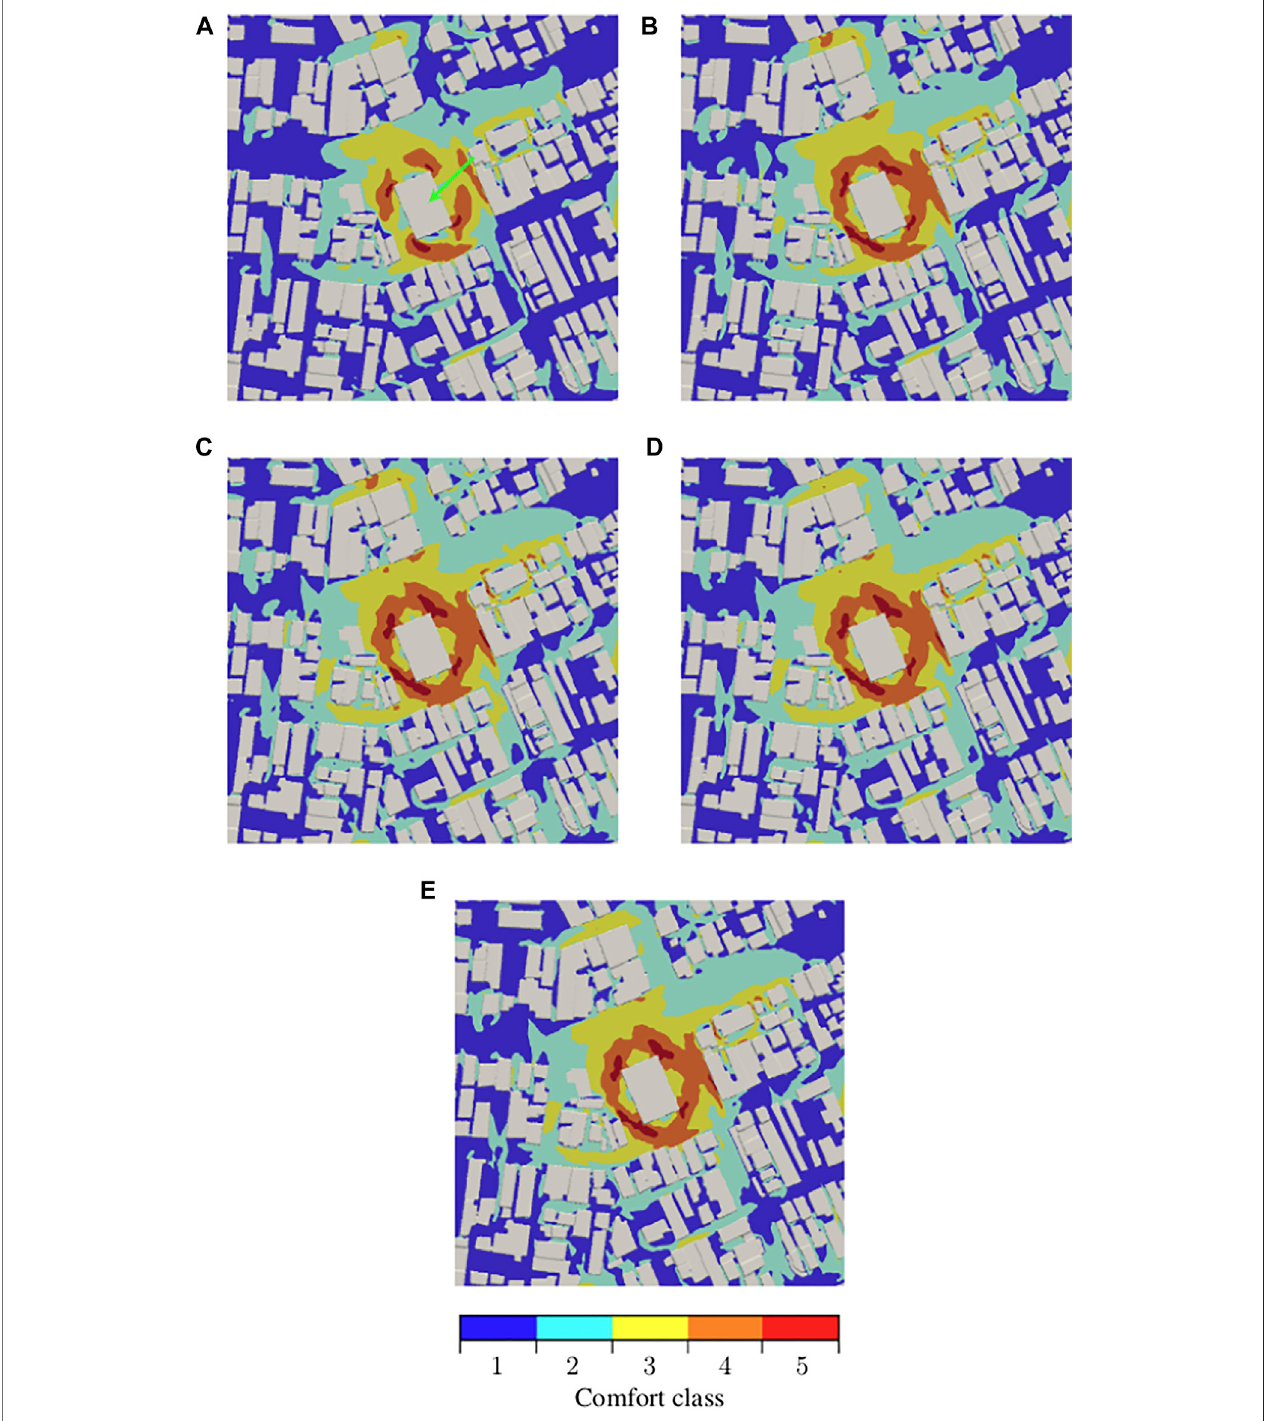
FIGURE 7 | Pedestrian wind comfort maps at 2 m above ground 100 m in each horizontal direction of the high-rise building indicated by the green arrow. Generated using (A) 4 (B) 8 (C) 16 (D) 32, and (E) 64 wind directions.